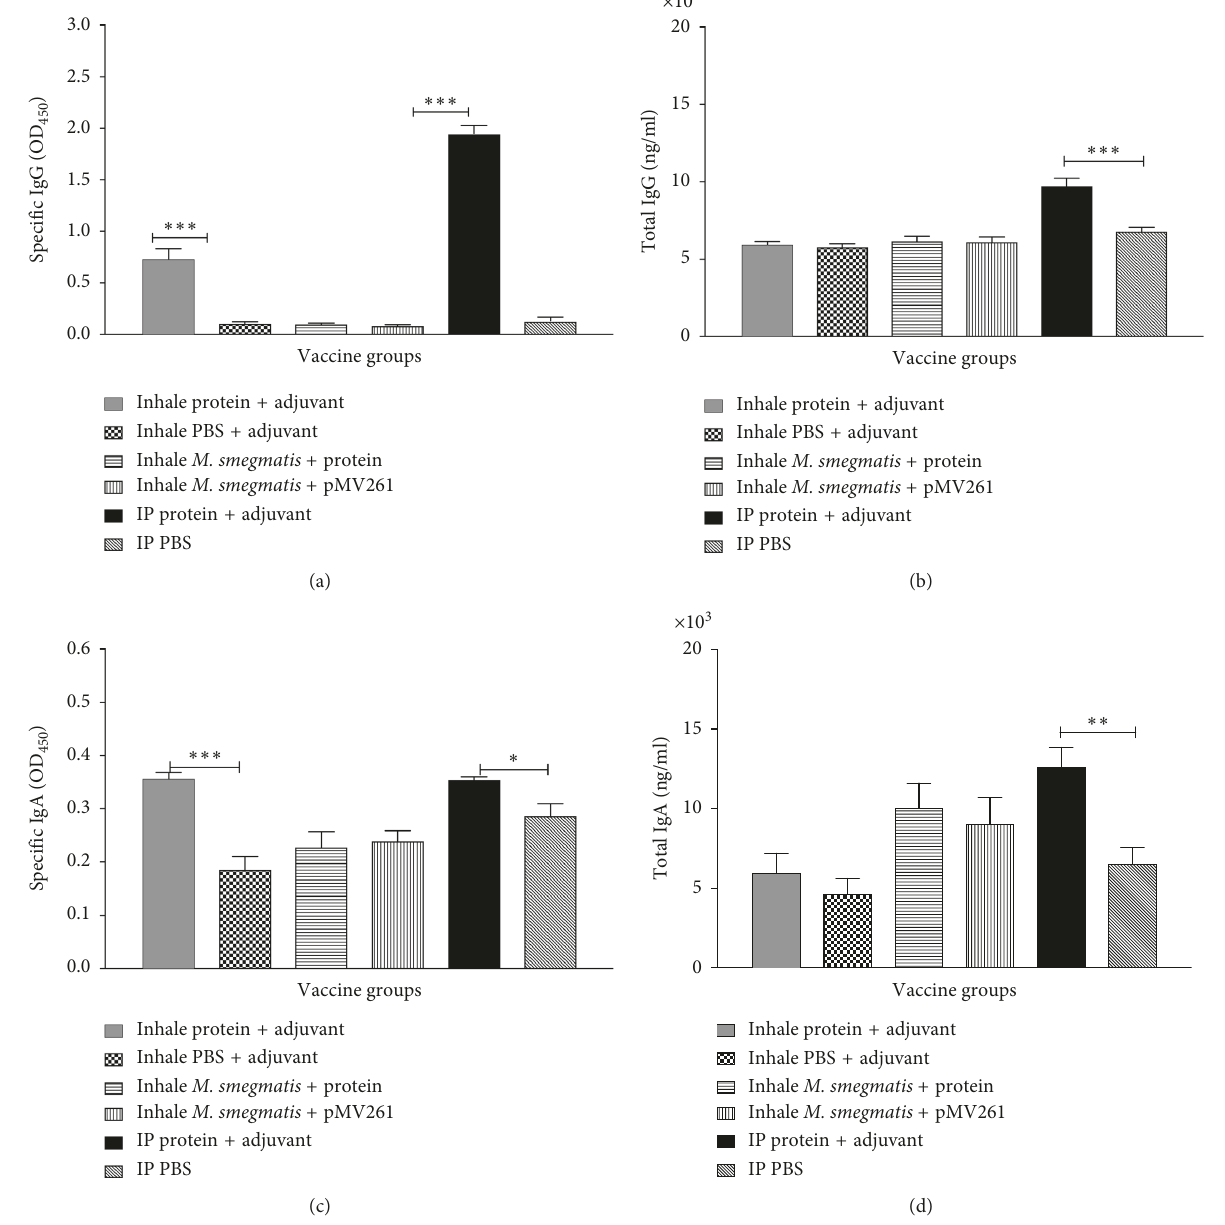
Figure 4: Specific and total antibody responses in C57BL/6 mice ( n = 9/group) immunized either intranasally or intraperitoneally with the mixture of M. bovis four recombinant surface antigens or with M. smegmatis clones overexpressing these antigens for a total of two times at weeks 0 and 1.5. All experimental groups of mice were intranasally challenged with 107 BCG preexposed to the granuloma-like conditions, and two weeks later, antisera were collected for IgG and lungs for IgA detection by ELISA. The results for specific IgG (a) and IgA (b) are presented as OD450, whereas total IgG (c) and IgA (d) levels are calculated in ng/ml for the individual mice, and the mean values for each group are